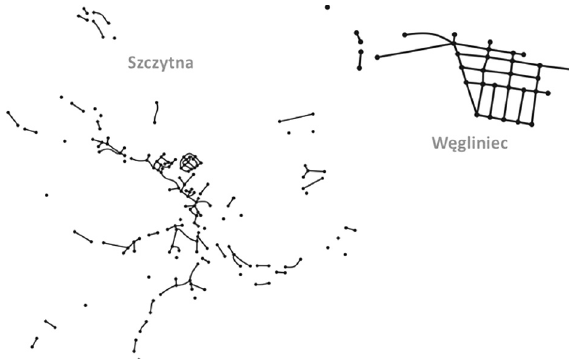
Fig. 10. Graphs depicting the morphology of degraded towns (DT). Source: own work.